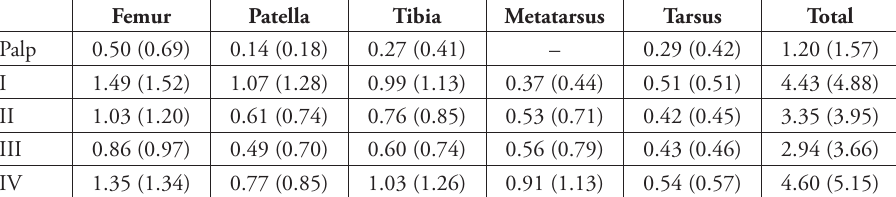
Leg measurements : male NCA 2008/4672 (female NCA 2008/2607 in parentheses): Femur Patella Tibia Metatarsus Tarsus Total Palp 0.50 (0.69) 0.14